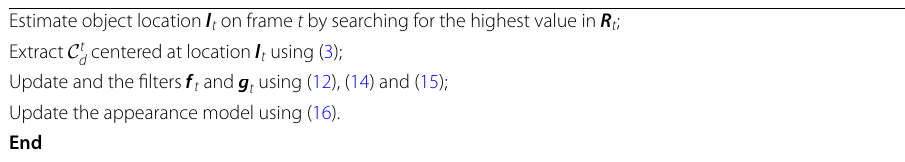
Algorithm1 The proposed tracking